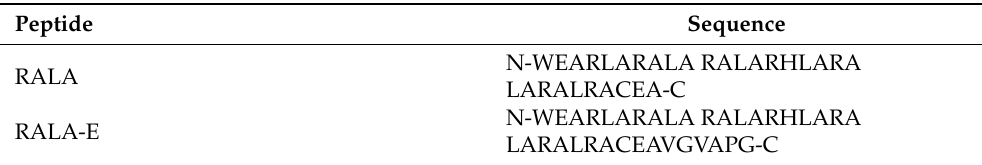
Table 1. The sequence of RALA and RALA-E peptides.